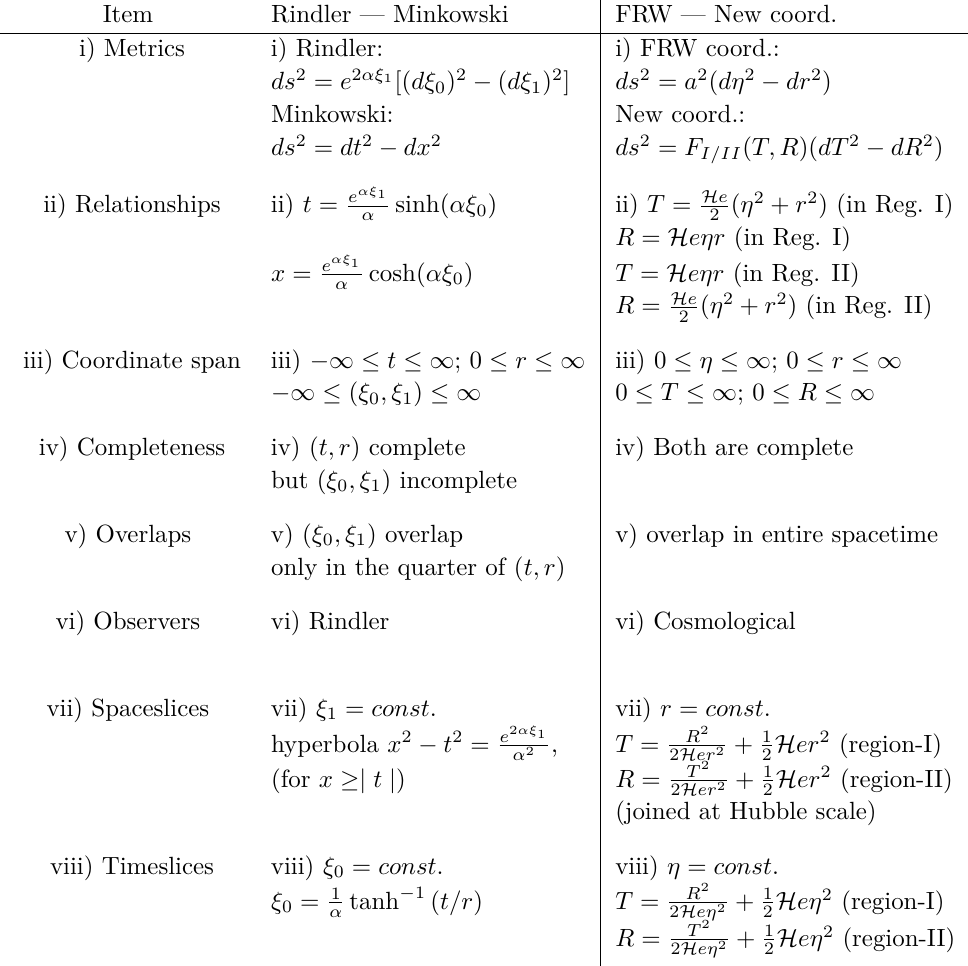
Table 1 . Analogy between the Rindler-Minkowski and FRW-New coordinates.